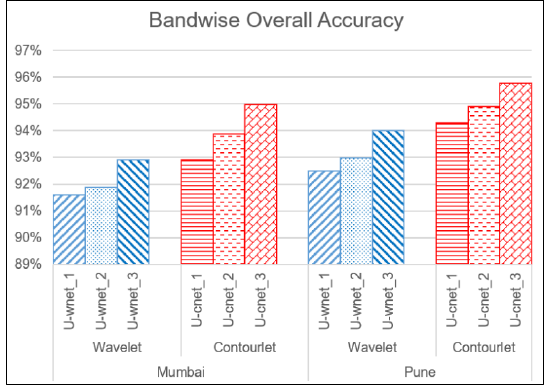
Figure 6. Effects of contourlet subbands with U-net for Mumbai image: ( a ) reference; ( b ) U-cnet_1; ( c ) U-cnet_2; ( d ) U-cnet_3.